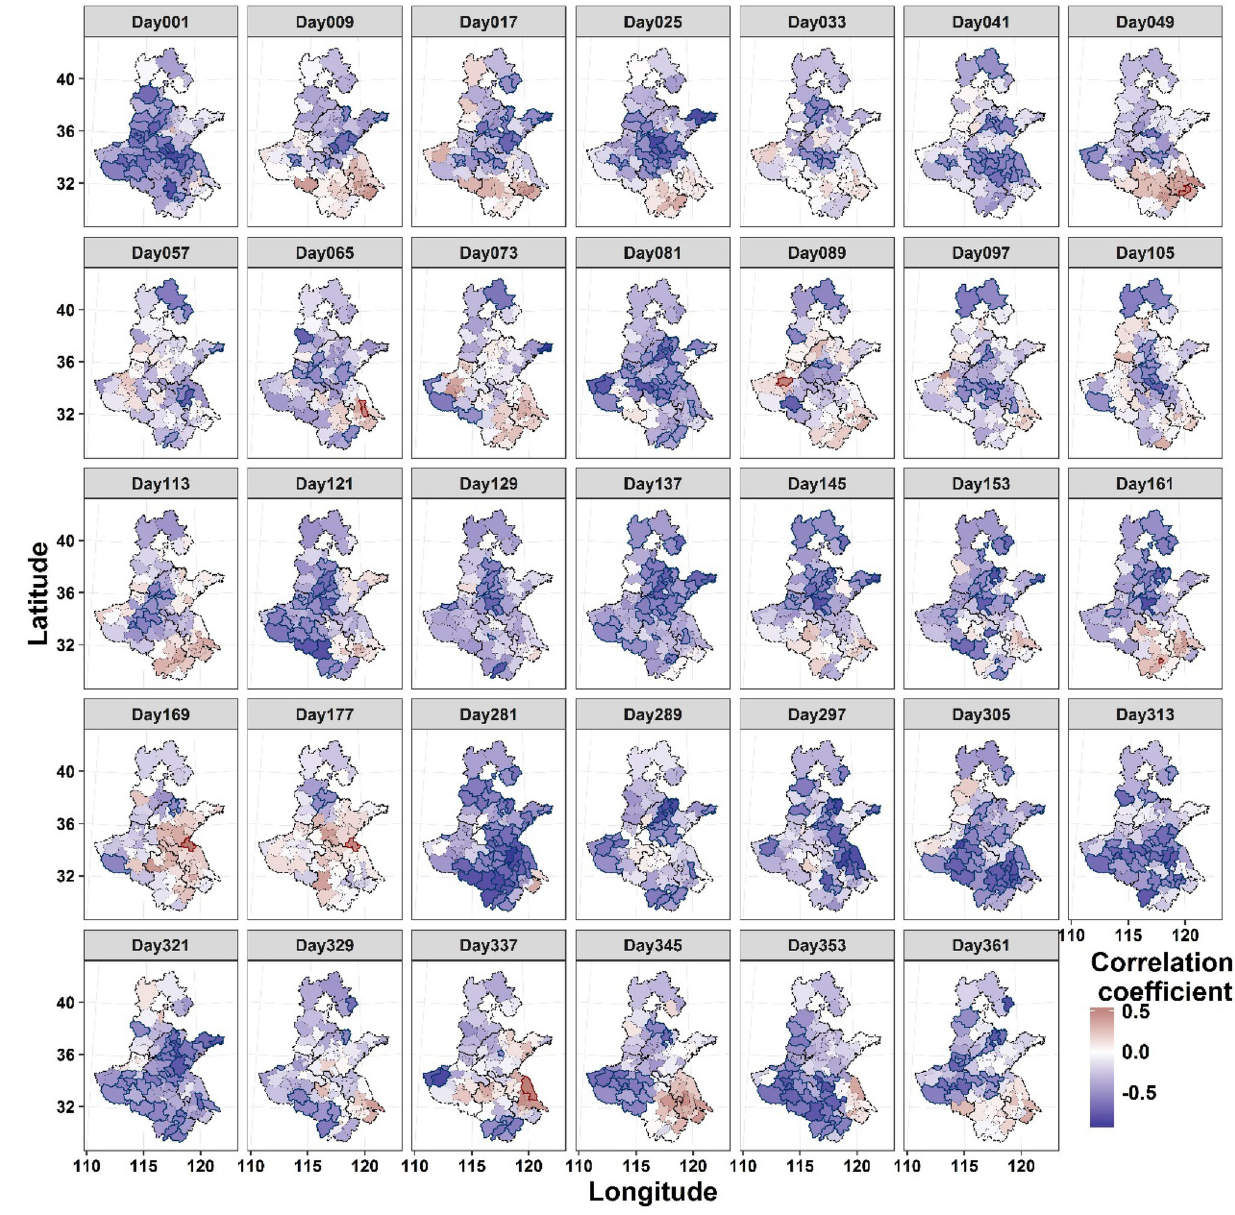
Fig. 10 Spatial pattern of correlations between extreme drought-affected crop area and winter wheat yield in Anhui, Hebei, Henan, Jiangsu, and Shandong Provinces, China,